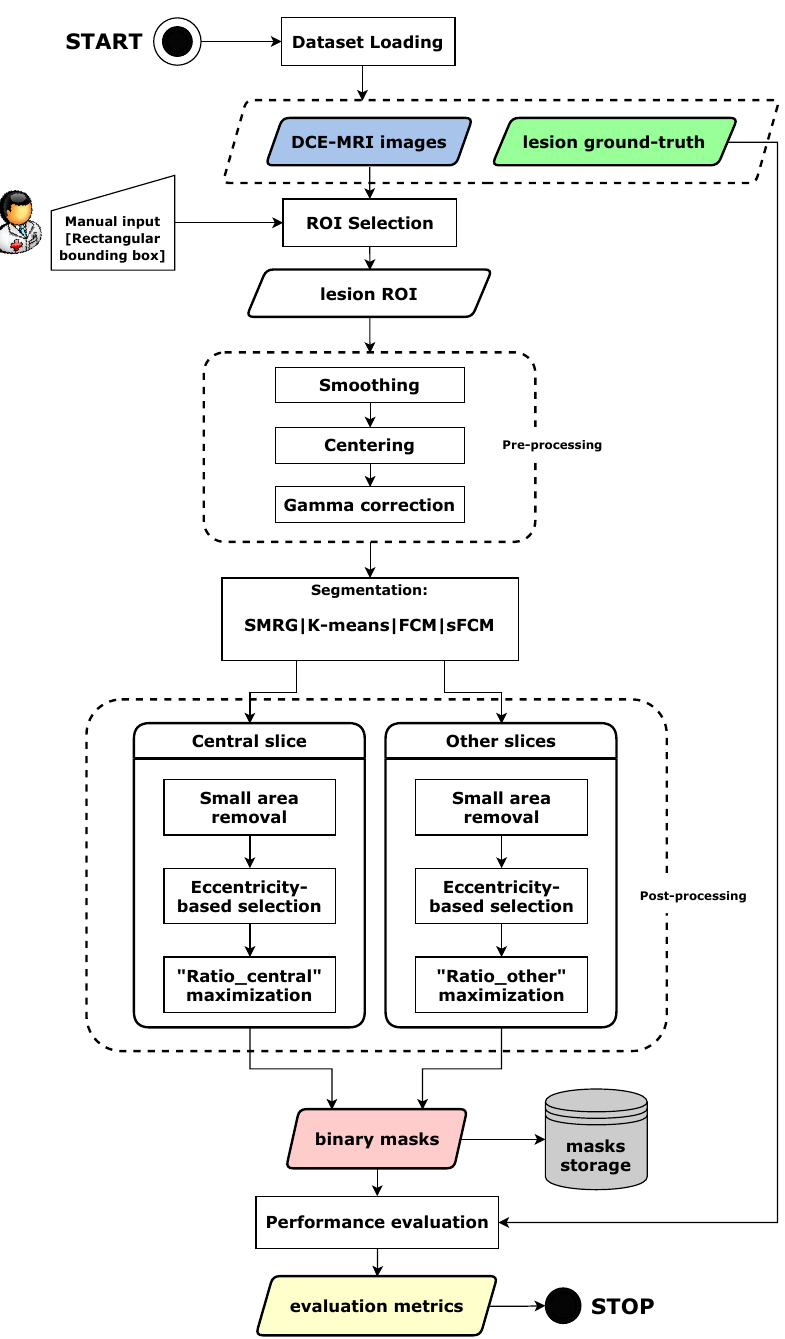
Figure 2. Flow diagram of the proposed analysis for breast lesion